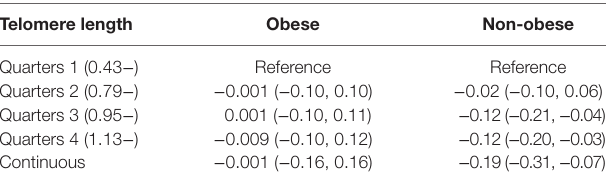
TaBle 3 | Association between telomere length and C-peptide by obesity, β (95%